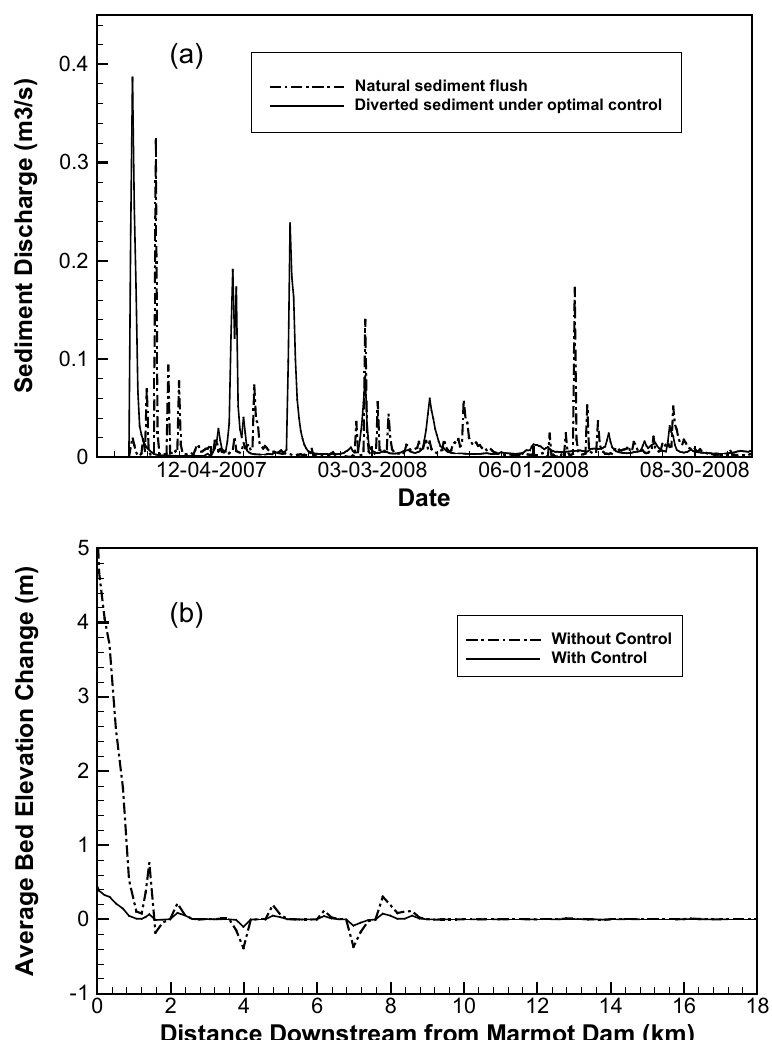
Fig. 6 Results of sediment control optimization: (a) Release rate from reservoir based on natural flush (dash-dot line) and the optimal control (solid line); (b) Morphological changes through the natural flush (without sediment release control) and the controlled sediment routing (solid